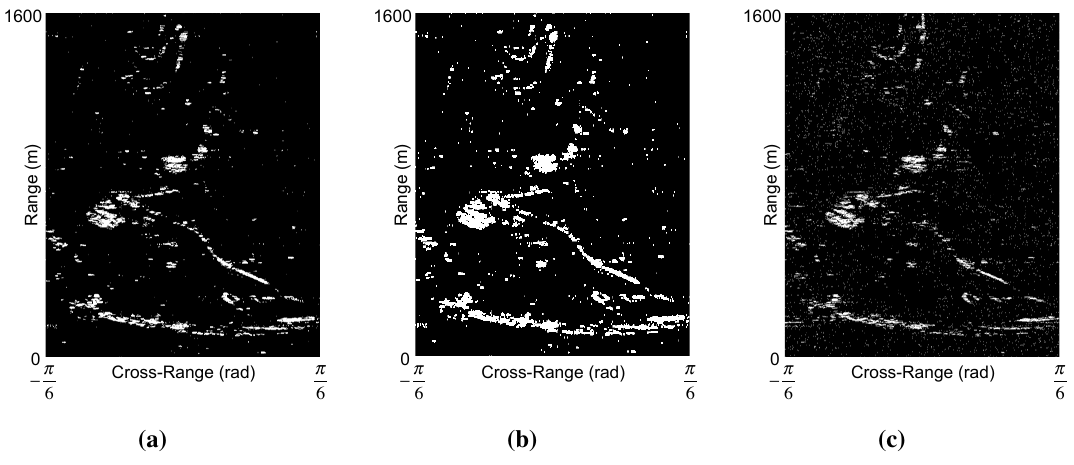
Figure 10. Pixel candidates selected using ( a ) the TSC with a threshold of 0 . 82 ; ( b ) the coherence stability with a threshold of 0 . 65 ; and ( c ) the D GB-SAR dataset.